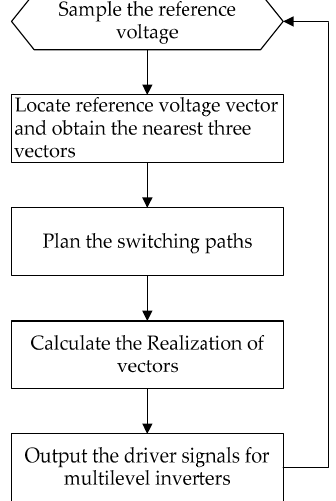
Figure 16. Flowchart of the implementation of the SVPWM scheme.